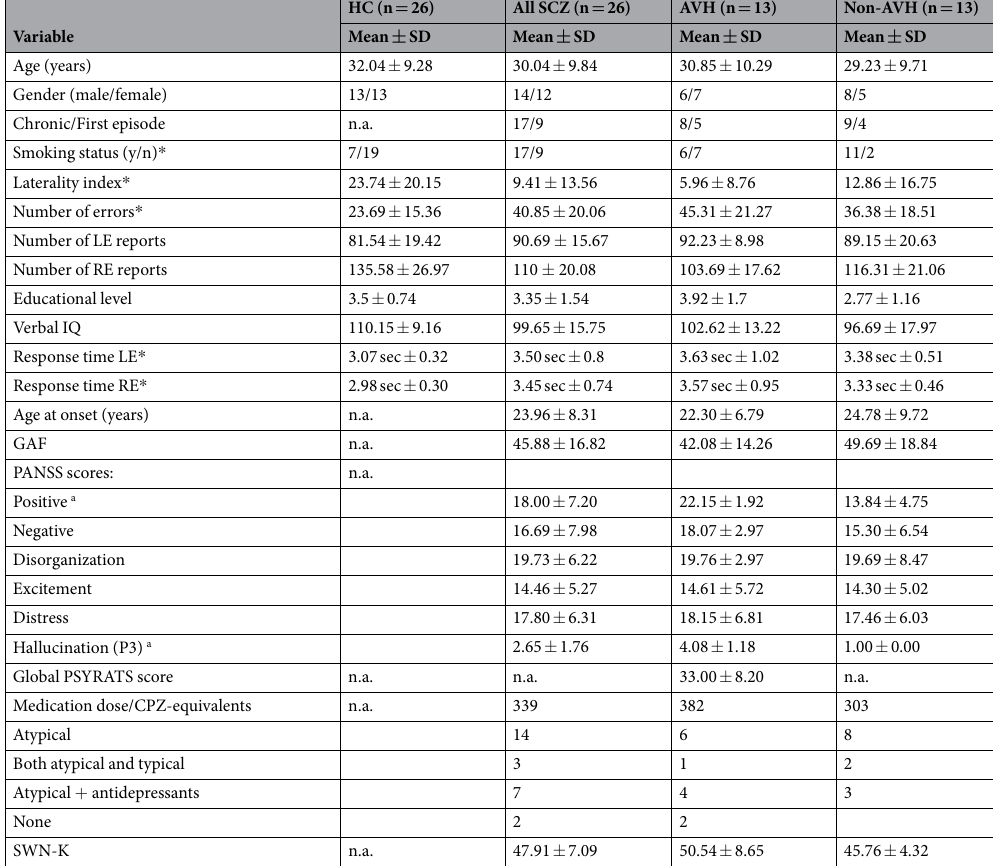
Table 1. Demographic and clinical characteristics of subjects: mean and standard deviation (SD) are given for each variable. HC, Healthy controls; SCZ, schizophrenia patients; AVH, patients with hallucinations; non- AVH, patients without hallucinations; SD, standard deviation; CPZ, chlorpromazine; n.a., not applicable; RE, right ear; LE, left ear; GAF, Global Assessment of Functioning; PANSS, Positive and negative symptom